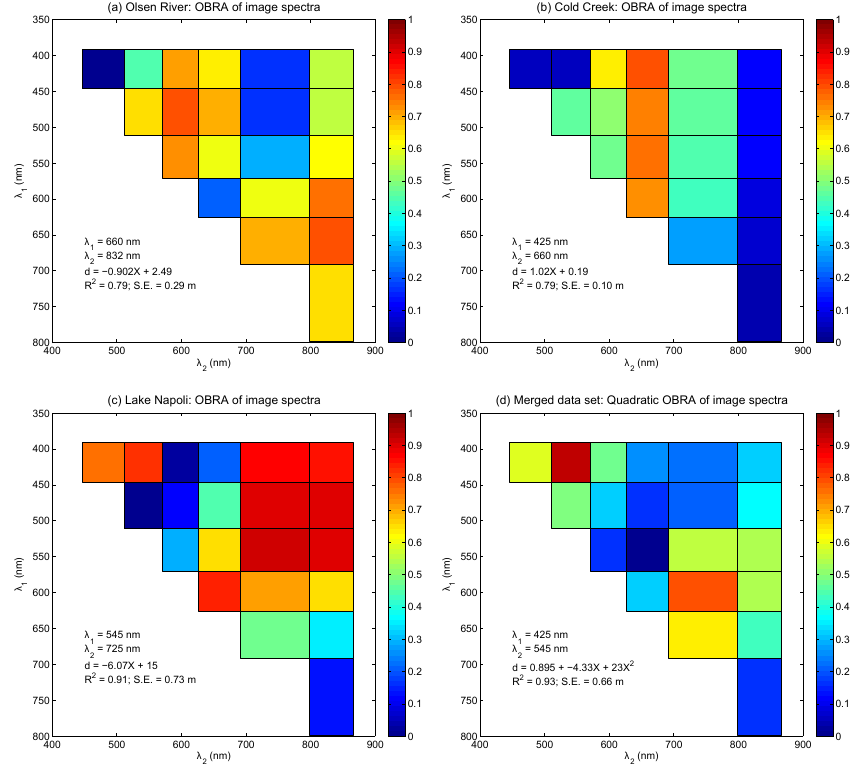
Fig. 6. OBRA of WV2 image spectra for each study site and for a merged data set aggregated across the three